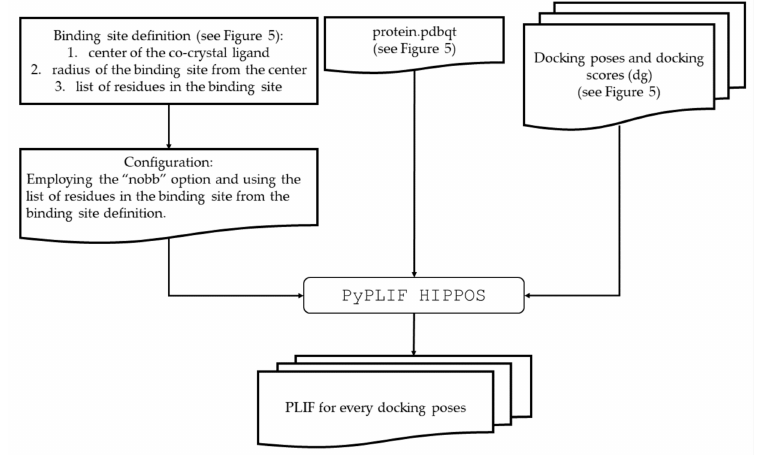
Figure 6. The procedure of the protein-ligand interaction fingerprinting (PLIF) identifications.